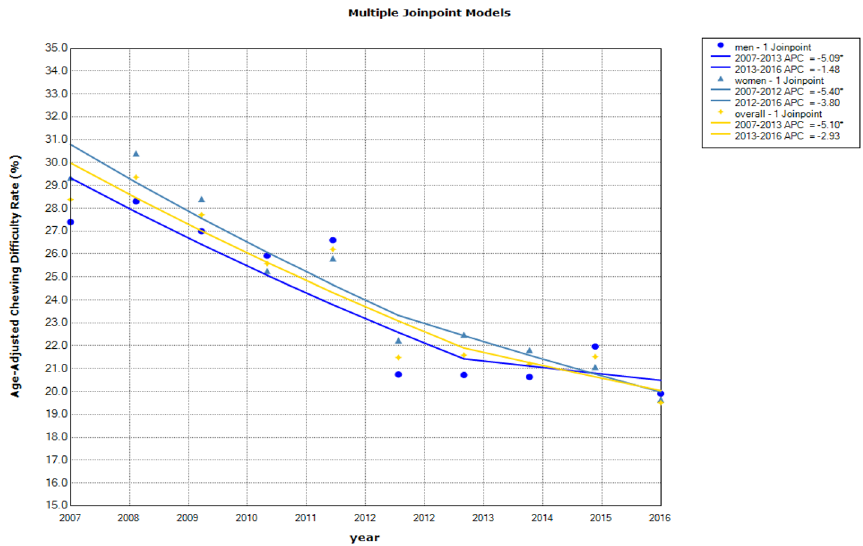
Figure 3. Multiple Joinpoint models of chewing difficulty. APC denotes annual percent